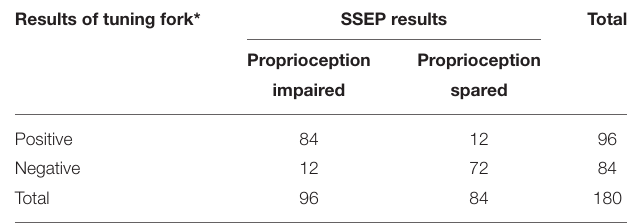
TABLE 6 | Results for 180 sites that were tested with VSA-3000 to distinguish between proprioception impaired and spared. Results of VSA-3000*